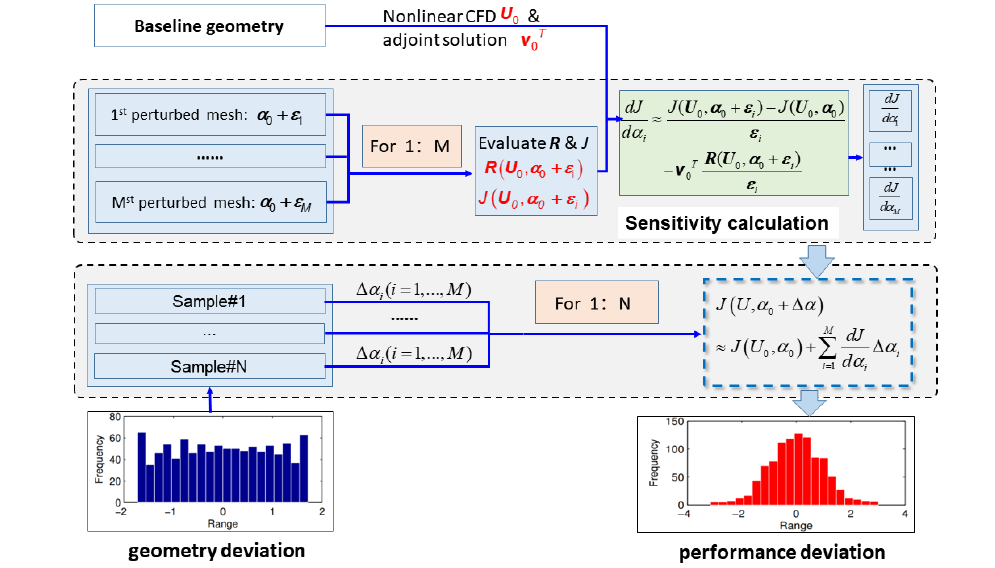
Figure 1. The diagram of the MC − adj − linear method